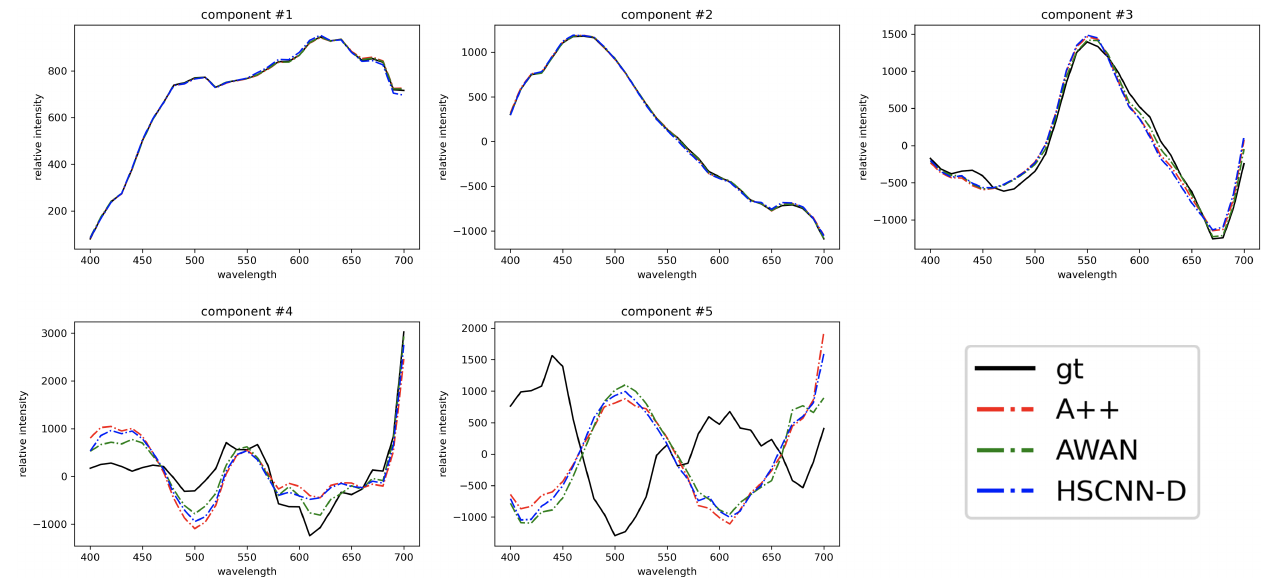
Figure 7. The top 5 Characteristic Vector Analysis (CVA) characteristic vectors of the ground-truth (gt; black curve), A++-recovered (red), AWAN-recovered (green) and HSCNN-D-recovered spectra (blue) in the testing image set. All recovered spectra are from original testing images without rotation or